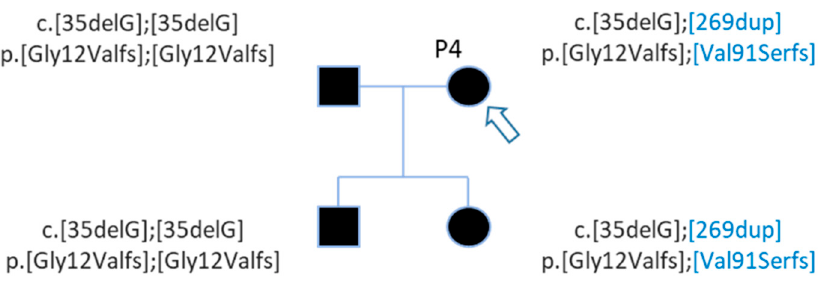
Figure 3. Pedigree of patient P4 with 2 GJB2 variants. Patient P4 (arrow) carries two GJB2 mutations, the c.35delG known before WGS and the c.269dup discovered by WGS analysis (in blue). WGS analysis detected mutations for her daughter also.